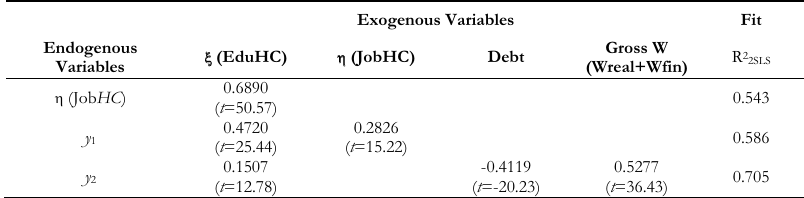
Estimation of parameters of bidimensional HC model Exogenous Variables